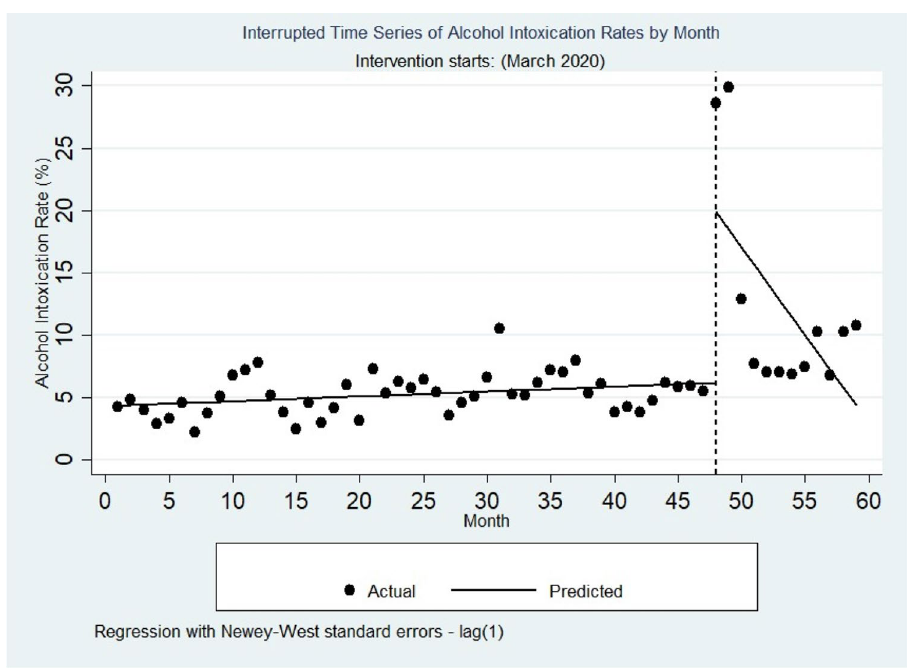
Figure 3. Interrupted time series of alcohol intoxication rates by